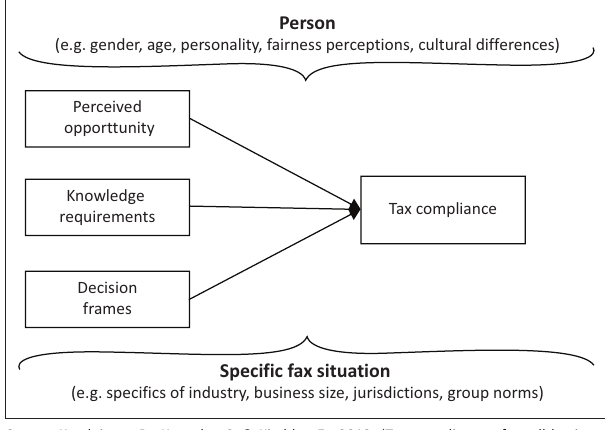
FIGURE 1: Framework of factors influencing small business owners’ tax